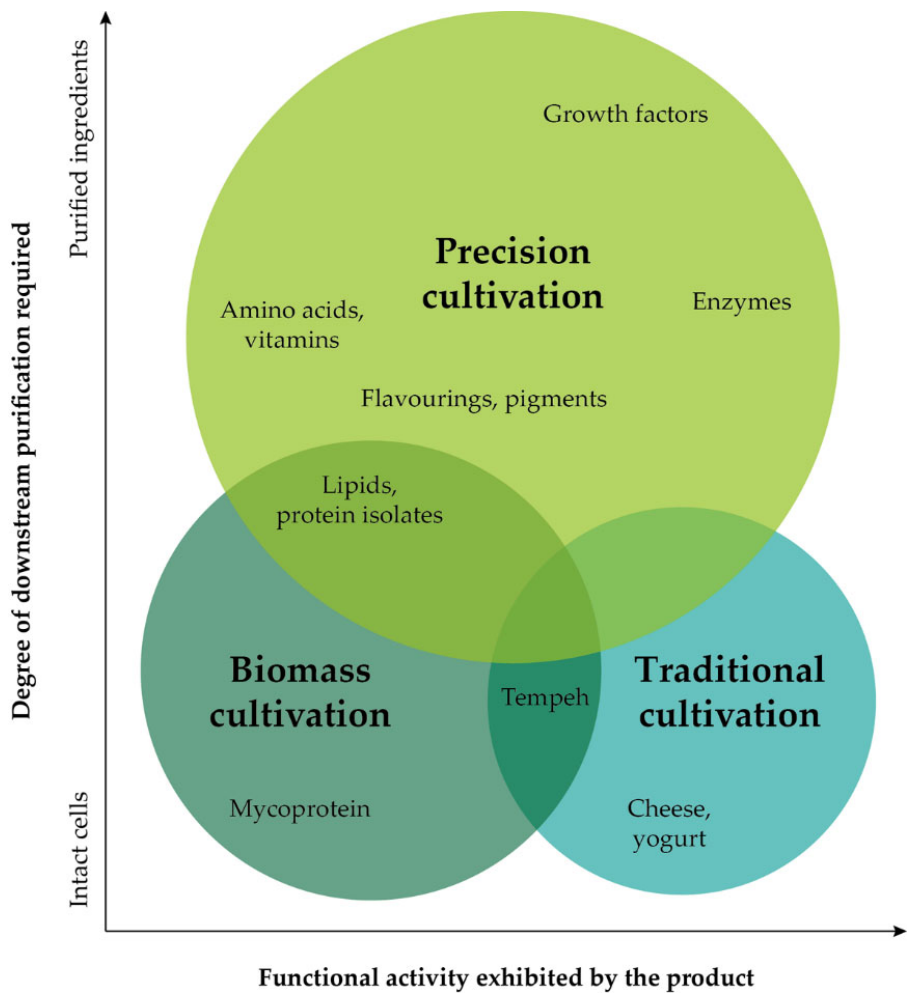
Figure 1. A conceptual landscape of cultivation ‐ derived and cultivation ‐ enabled products [35].